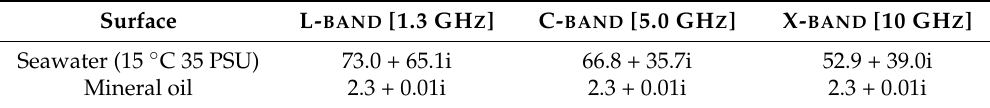
Table 1. Dielectric Constant of seawater from [25] and mineral oil from